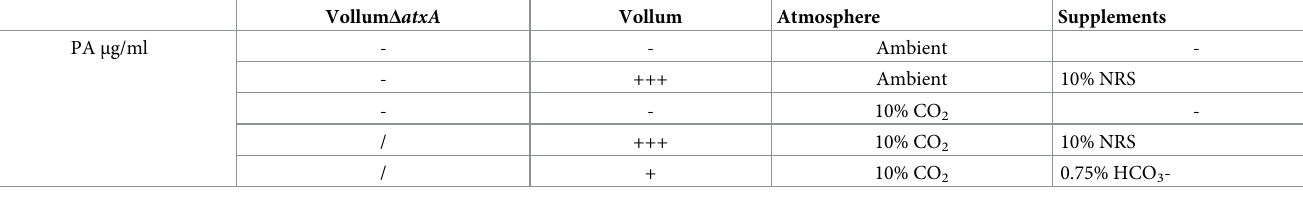
Table 3. PA secretion ( μ g/ml) by Vollum and Vollum Δ atxA following 5h growth in different